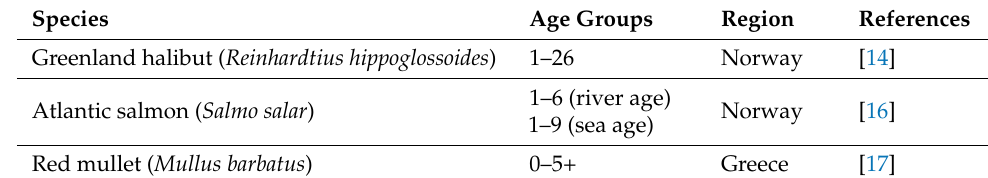
Figure 2. Fish species that are currently processed through the DeepOtolith platform: ( a ) Greenland halibut ( Reinhardtius hippoglossoides ) otolith, ( b ) Atlantic salmon ( Salmo salar ) scale, and ( c ) red mullet ( Mullus barbatus ) otolith. Table 1. Fish species that are currently available on the DeepOtolith platform.